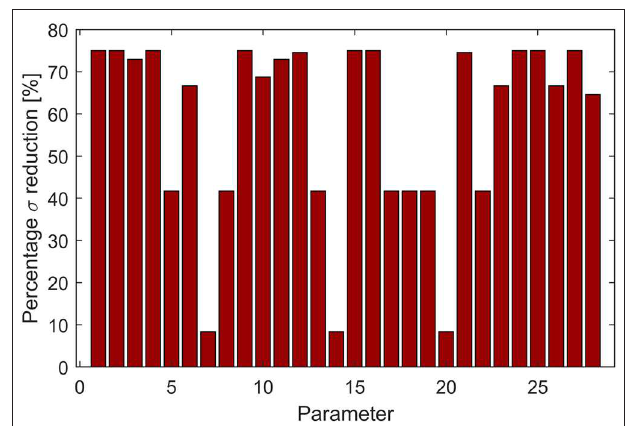
FIGURE 10 | Minimum percentage standard deviation reduction on the selected parameters sub-set required in order to ensure an output uncertainty lower than the